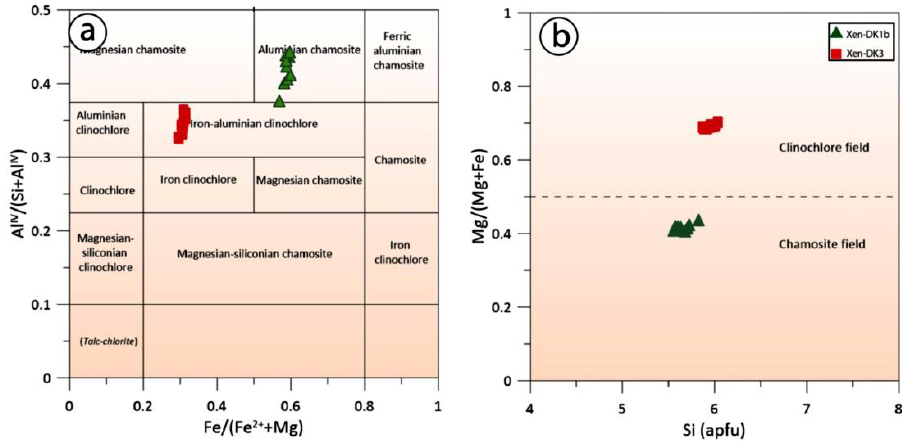
Figure 6. Compositional variations of chlorites in terms of ( a ) Fe/(Mg+Fe2+) versus AlIV/ (Si+Al IV )[20]. ( b ) Mg/ (Mg+ Fe) versus Si [21] from diorite and microdiorite enclaves (cations/28 ox- ygen atoms). Table 2. Representative major-element compositions of chlorite from studied diorite and microdio- rite enclaves .